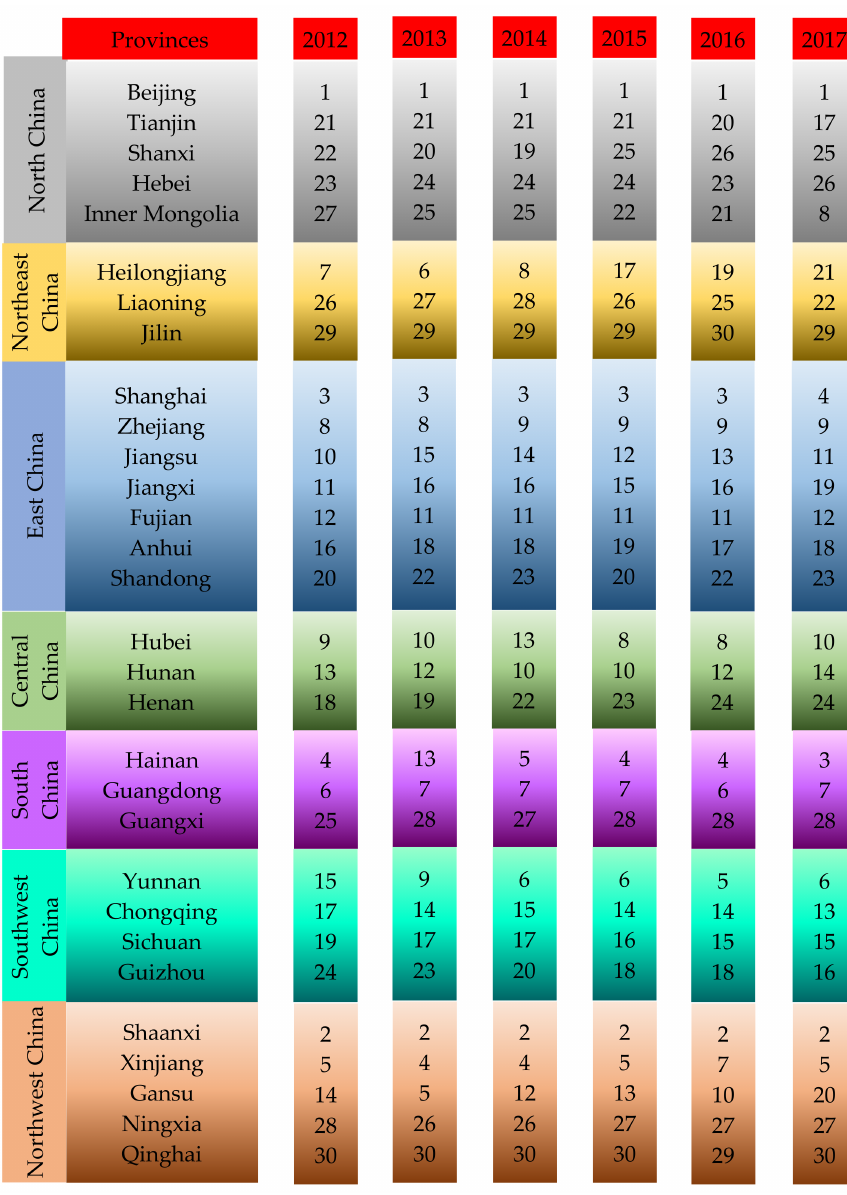
Figure 5. The EEE rankings of the industrial sector in various provinces from